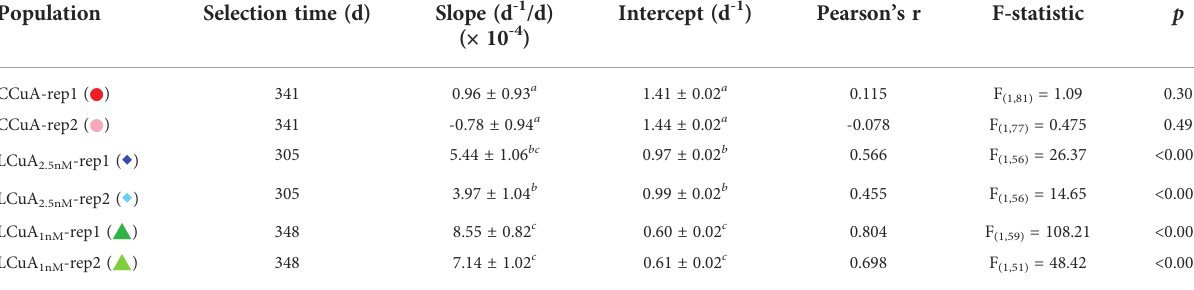
TABLE 1 Linear regression statistics of growth rate (d -1 ) of low Cu-adapted (LCuA 1nM and LCuA 2.5nM ) and control (CCuA) populations as a function of selection time for the initial selection experiment.